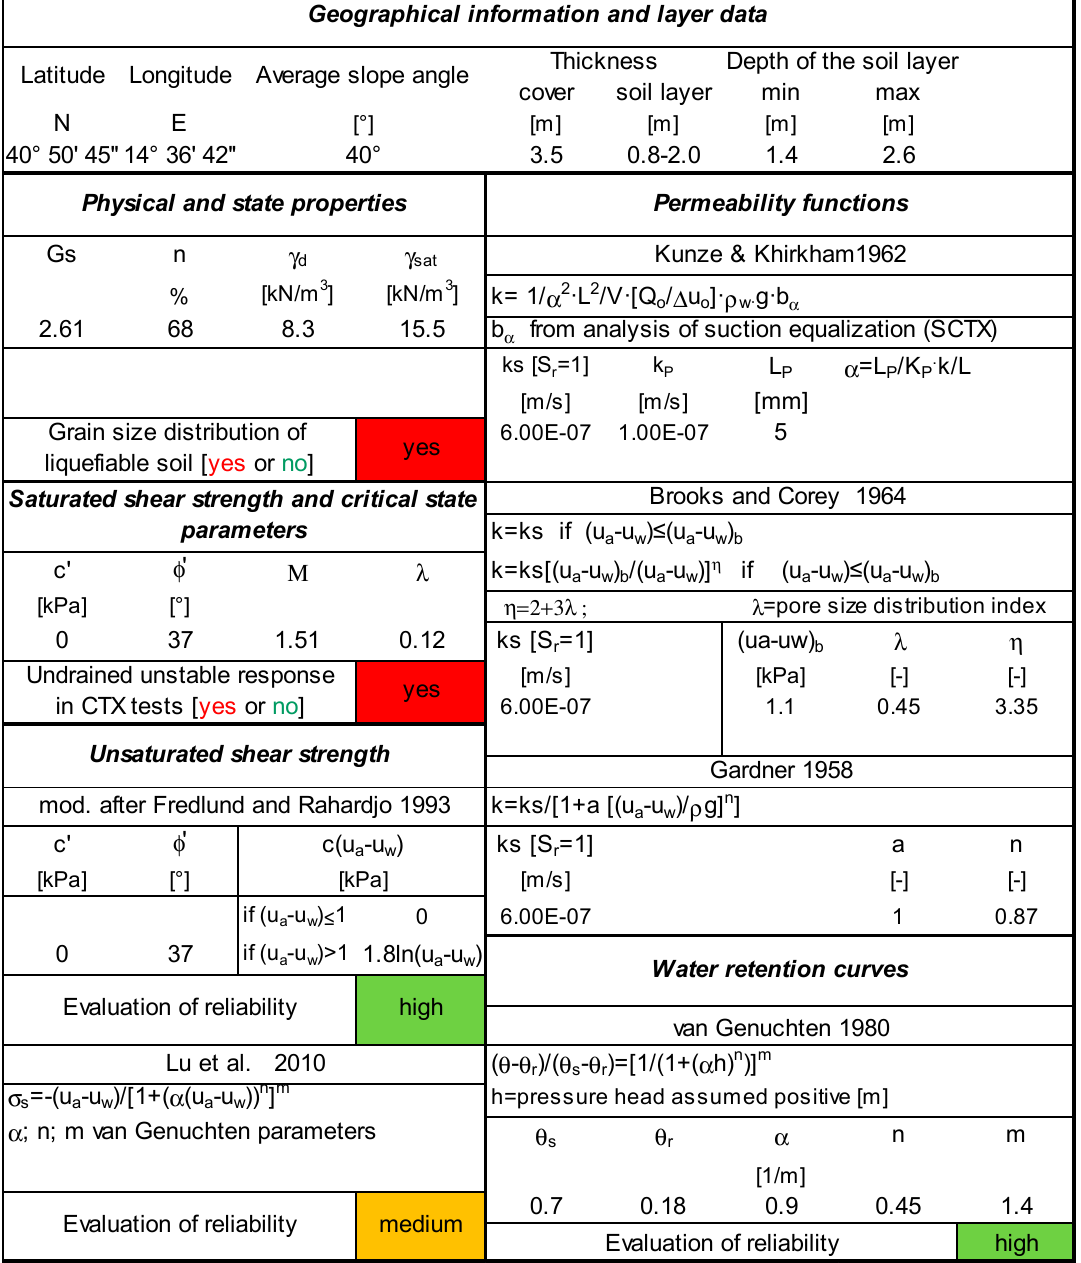
Figure 9. Soil database for Sarno pyroclastic ash (evaluation of reliability: high if relationship reproduces the trend of experimental data; medium if relationship reproduces only qualitatively the trend of experimental data; low if relationship does not reproduce the trend of experimental data at all).